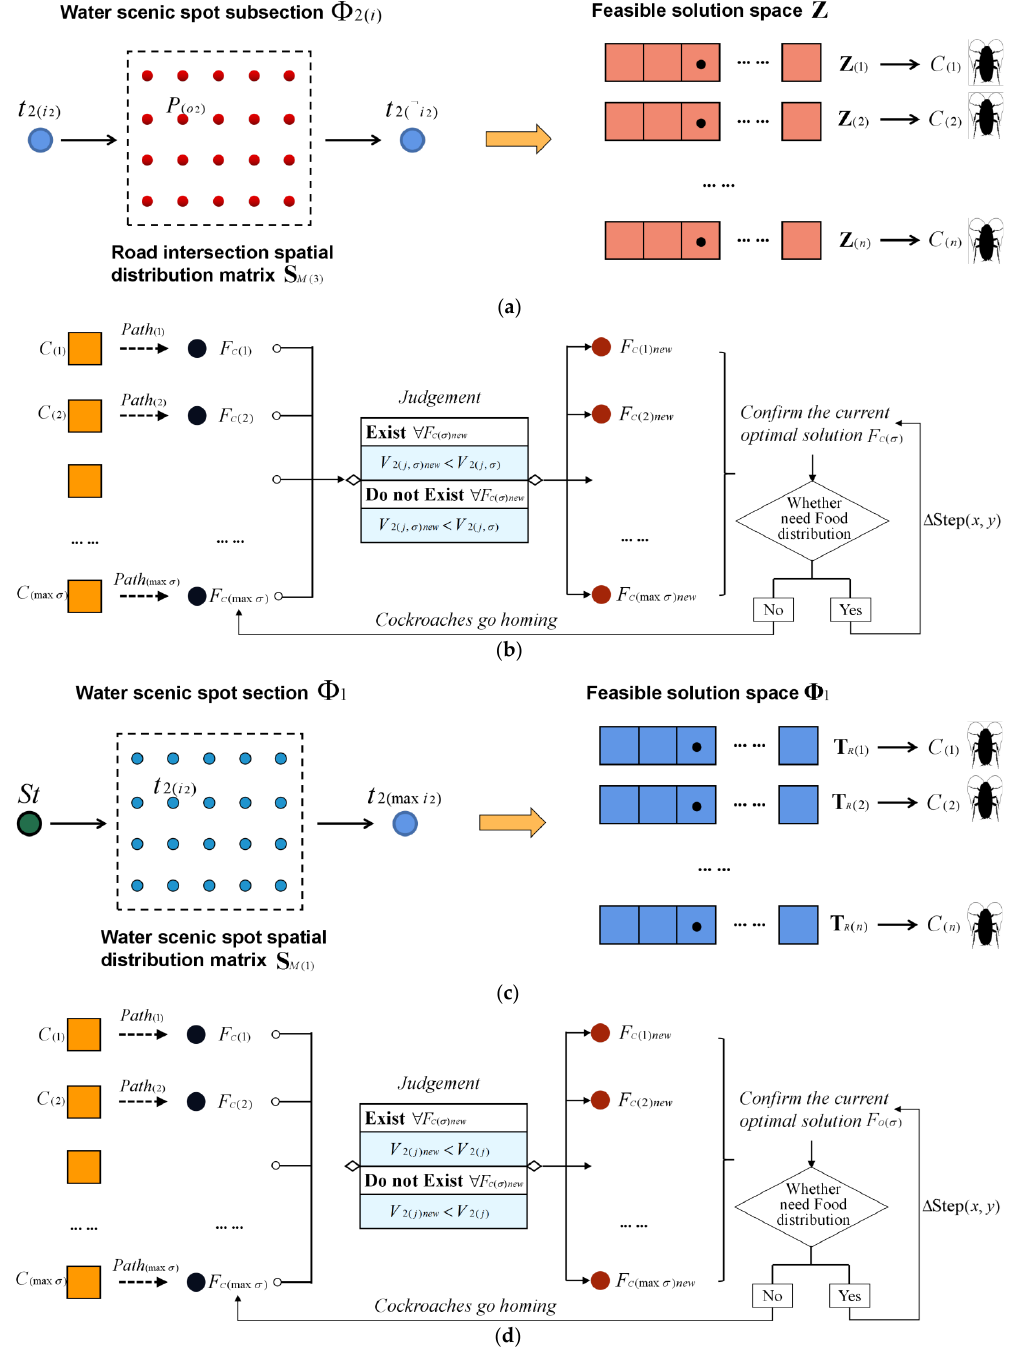
Figure 2. The modeling process of the water ecotourism recommendation model. ( a ) shows the generation of each cockroach for the feasible path solution in the water scenic spot subsection. ( b ) shows the process to search the optimal path in one subsection. ( c ) shows the generation of each cockroach for the feasible tour route solution in the water scenic spot section. ( d ) shows the process to search the optimal tour route.